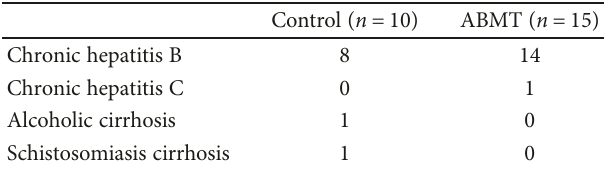
Table 1: Group division. Table 2: Clinical characteristics of